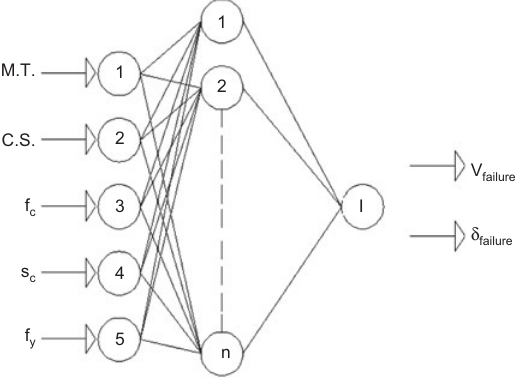
Figure 4 An ANN architecture used for level change estimation.